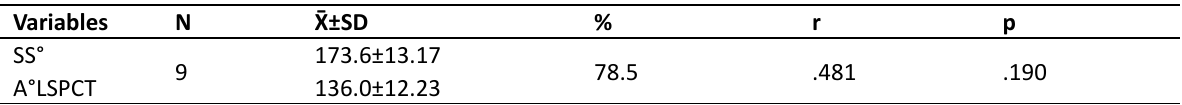
Table 2. Functional active flexibility “Side Split (SS°)” during the execution of the techniques requiring mobility “Leg Split in Handstand Position in Cartwheel Technique (A°LSPCT)” Variables